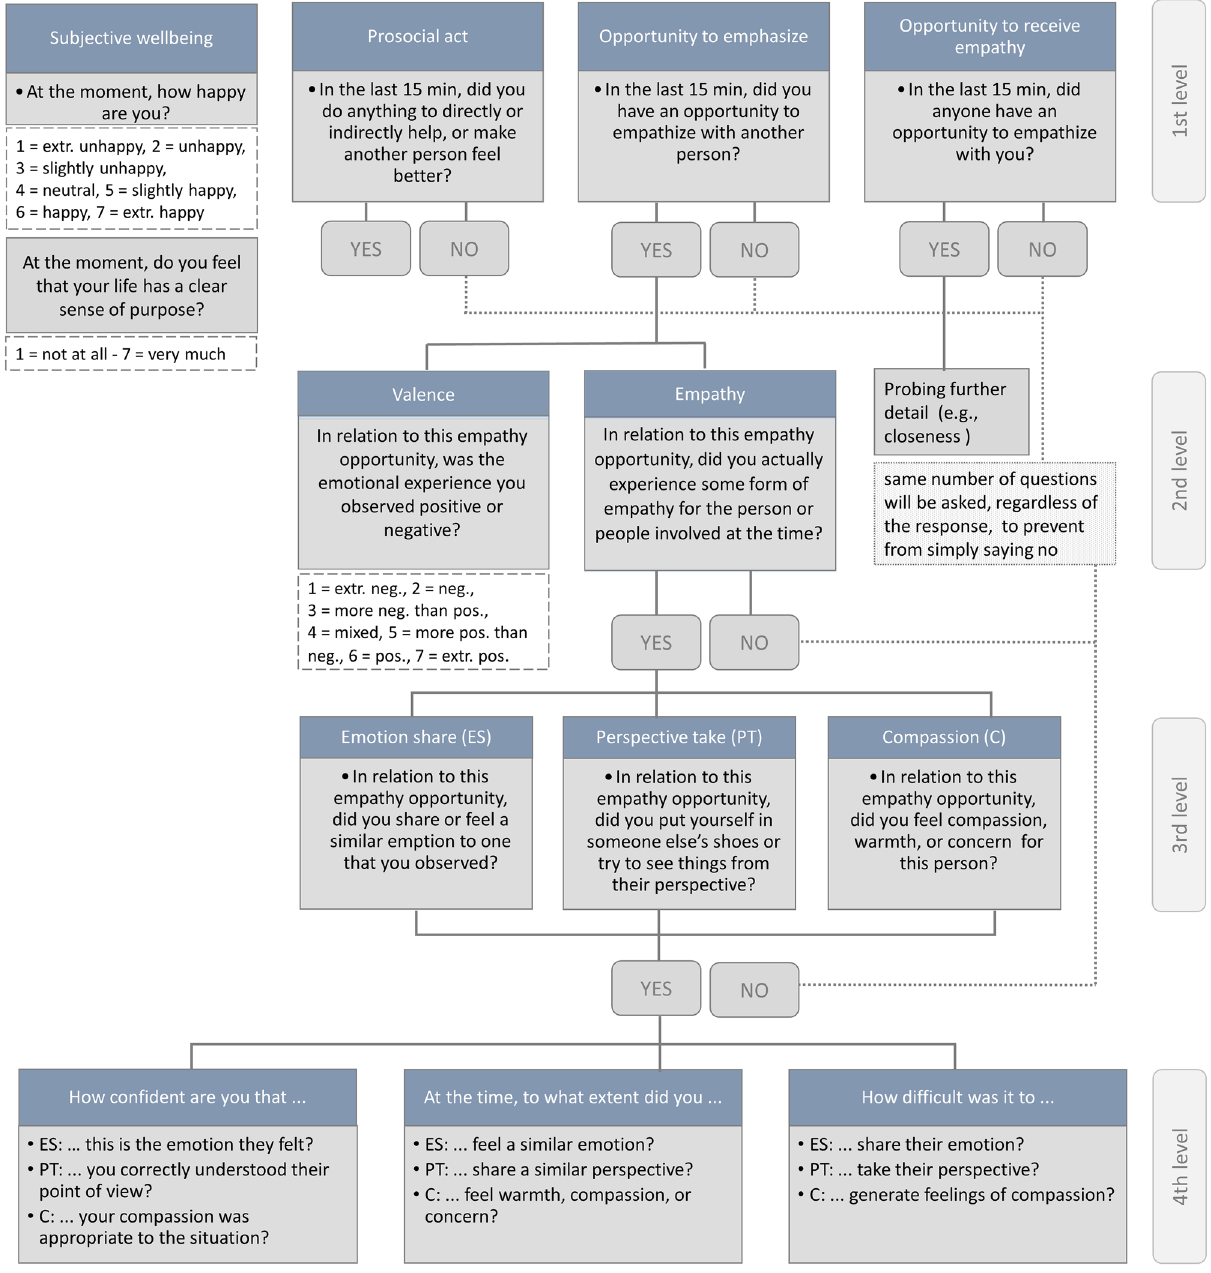
Figure 1. Daily survey design, visualizing the different survey levels and related questions. Only the questions relevant for the current study are depicted here. For further details, and a full study protocol, see Depow and colleagues 63 . Note that empathy (level 2) was assessed as an umbrella term, thus, questions about the subcomponents (level 3) emotion share, perspective taking, and compassion were only rated if the participant indicated to have actual feelings of empathy on level 2 of the survey. For each reported subcomponent on level 3, participants were asked about confidence, extent, and difficulty on level 4 of the